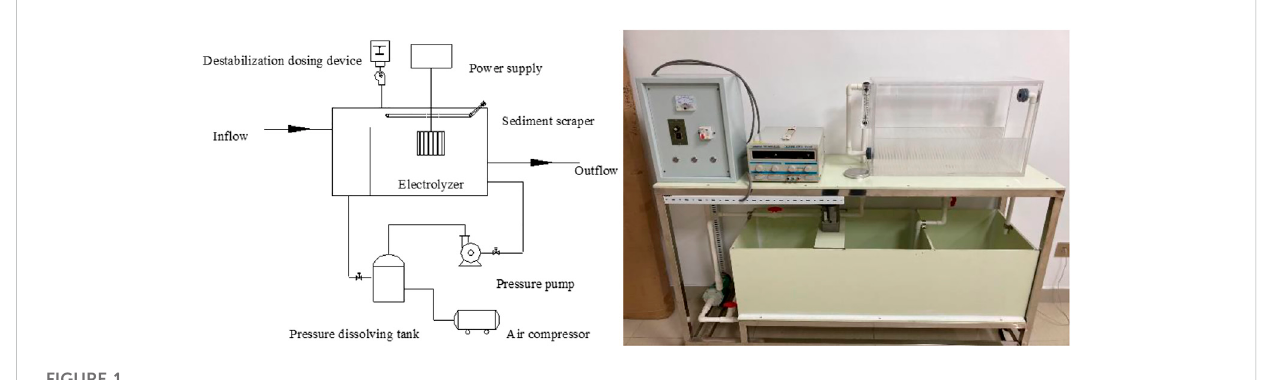
FIGURE 1 Electro- fl otation device.